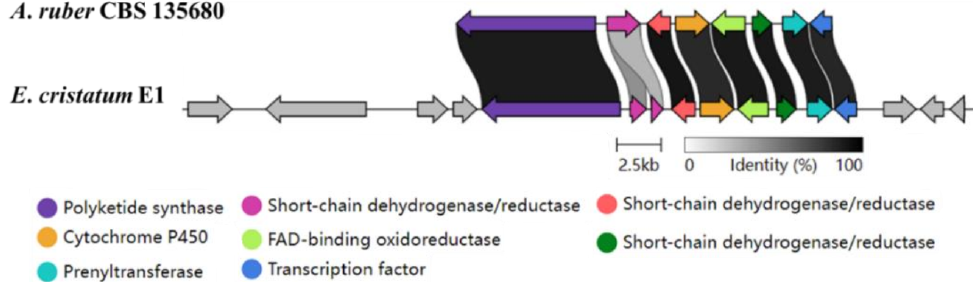
Figure 6. The comparison of flavoglaucin gene cluster in Eurotium cristatum E1 and fog cluster in A. ruber CBS 135680. Each gene is indicated by an arrow. The homologous genes are shown in the same color, and other genes in gray. The genes of A7192 gene cluster in Eurotium cristatum E1 from left to right: A7187 , A7189 , A7190 , A7191 , A7192 , A7193 , A7194 , A7195 , A7196 , A7197 , A7198 , A7200 , A7202 , A7203 , A7204 , A7205